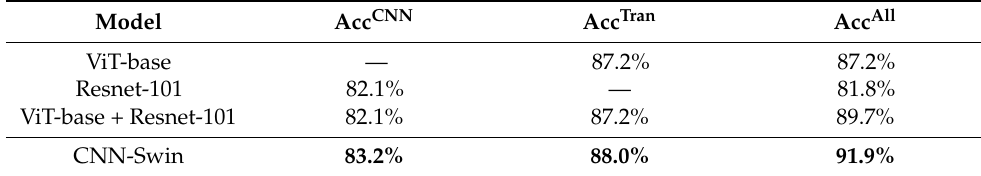
Table 6. Performance comparison of single branch.